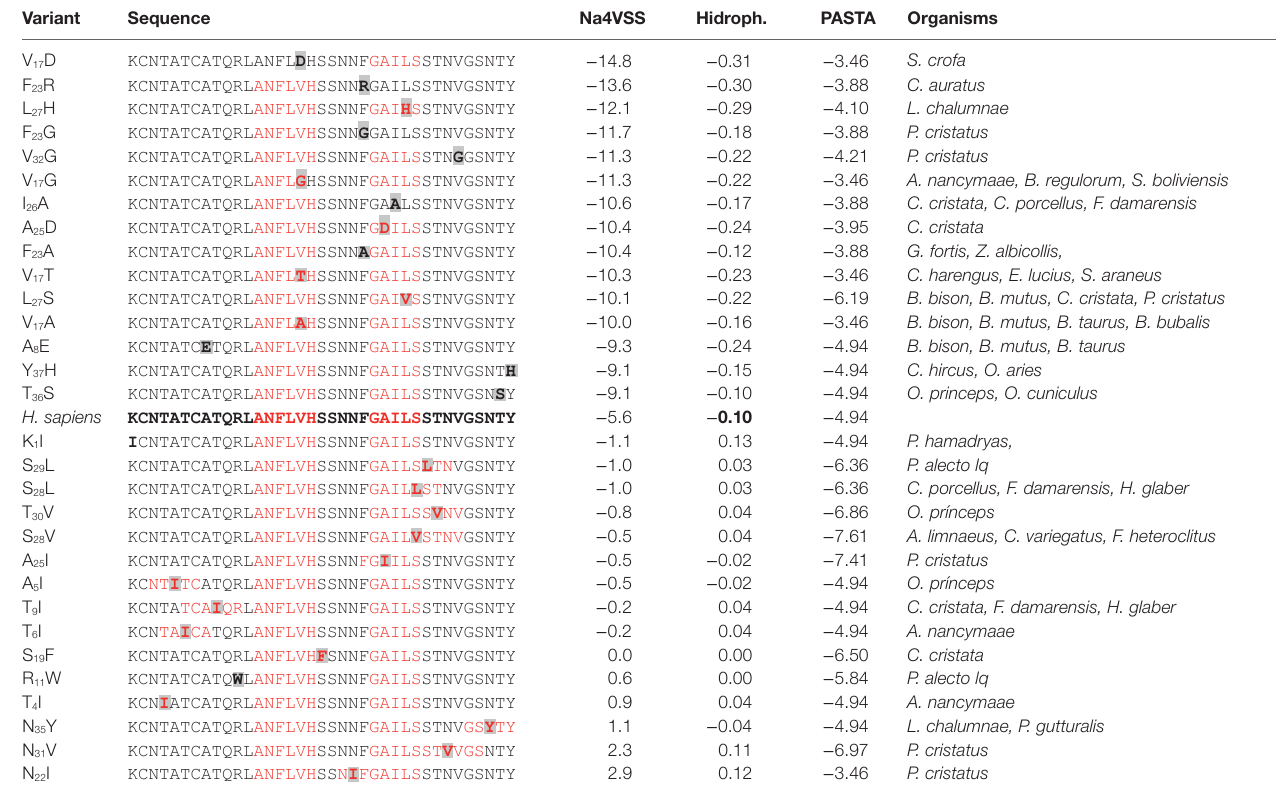
TaBle 2 | Effect of substitutions of individual variants on human amylin sequence.